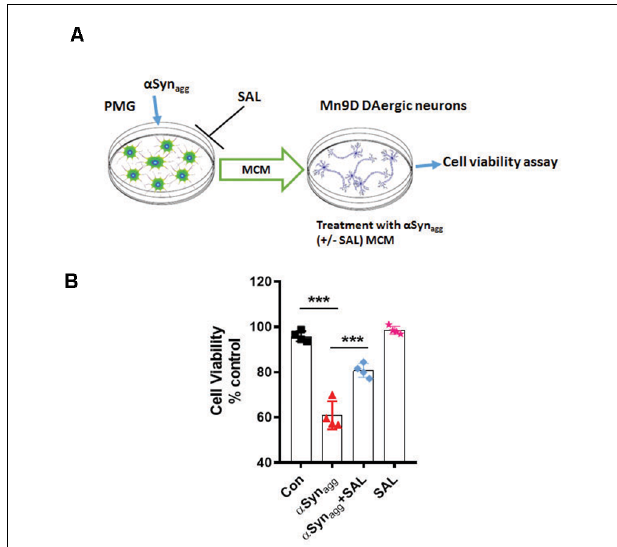
FIGURE 8 | Salubrinal attenuates α Syn agg -stimulated microglia-conditioned media (MCM)-induced DAergic neurotoxicity. (A) Schematic diagram depicting the treatment of MN9D DAergic neuronal cells with MCM from α Syn α Syn agg -stimulated primary microglia. (B) SAL reduced agg MCM-induced DAergic cell death. Mouse PMG was incubated with α Syn agg for 24 h, and subsequently, MCM from α Syn agg -treated microglia with or without SAL was applied to MN9D DAergic neuronal cells for 12 h. At the end of the incubation period, an MTS assay was performed to determine the cell viability of MN9D DAergic neuronal cells. Data shown are the mean ± SEM from at least four independent experiments. Data were analyzed using one-way ANOVA followed by Bonferroni’s post hoc analysis. Asterisks (*** p < 0.001) indicate significant differences between control and treatment